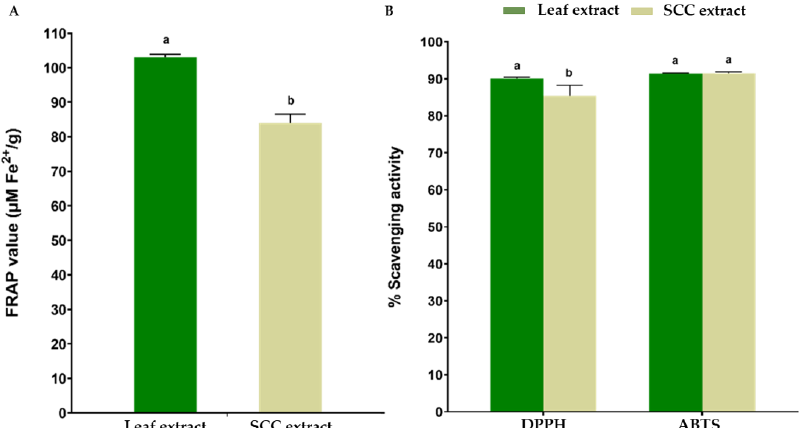
Figure 5. Antioxidant capacity of the ethanolic leaf and SCC extracts of R. nasutus ( A ) as determined by FRAP assay and ( B ) by DPPH and ABTS assays. The data are presented as the means ± SD of the results of triplicate determinations. Bars with different letters are significantly different according to an independent-samples t test at p ≤ 0.05.